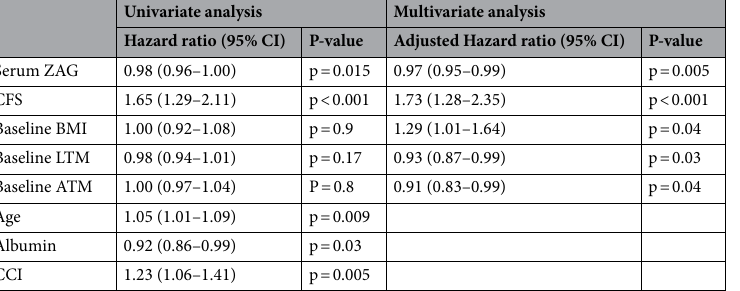
Table 5. Cox regression on survival. CI confidence interval, ZAG zinc alpha-2-glycoprotein, CFS Clinical Frailty Scale, BMI body mass index, LTM lean tissue mass, ATM adipose tissue mass, CCI Charlson Comorbidity Index. Co-variates included in model: age, gender, residual renal function, albumin, high sensitive C-reactive protein, low density lipoprotein, CCI, presence of ischemic heart disease, CFS, baseline body mass index, adipose tissue mass (ATM) and LTM, absolute change of ATM and LTM, serum ZAG.